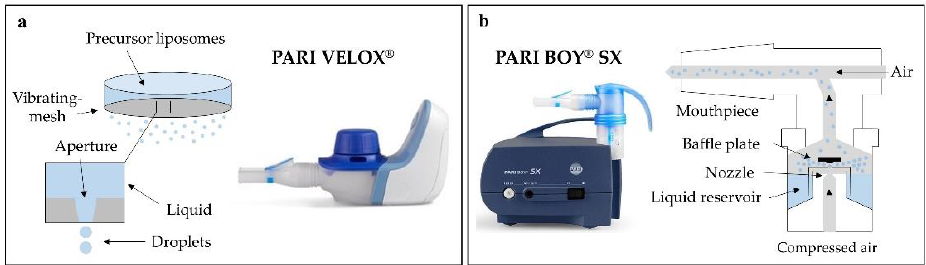
Figure 1. Operating mode of both techniques: ( a ) vibrating-mesh nebulization, ( b ) air-jet nebulisa- tion.